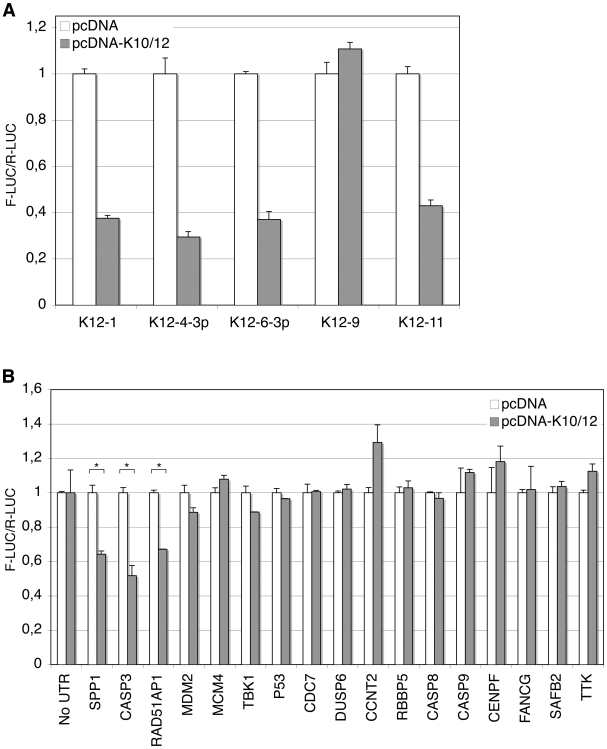
Validation of putative targets of KSHV miRNAs by luciferase assays.Luciferase assays were performed in triplicate 48 h post-transfection. The experiments were repeated at least 3 times, and one representative experiment is shown. A. KSHV miRNAs expressed from the pcDNA-K10/12 plasmid, but not miR-K12-9, can regulate the expression of sensor constructs containing complementary sequence to individual KSHV miRNAs. All differences but for miR-K12-9 were statistically significant (p<0.01). B. Dual-luciferase assay with psiCHECK-2 constructs containing either no UTR, or the indicated 3′ UTR. 293A cells were co-transfected with the luciferase construct and an empty pcDNA, or pcDNA-K10/12 construct. (* p<0.01).